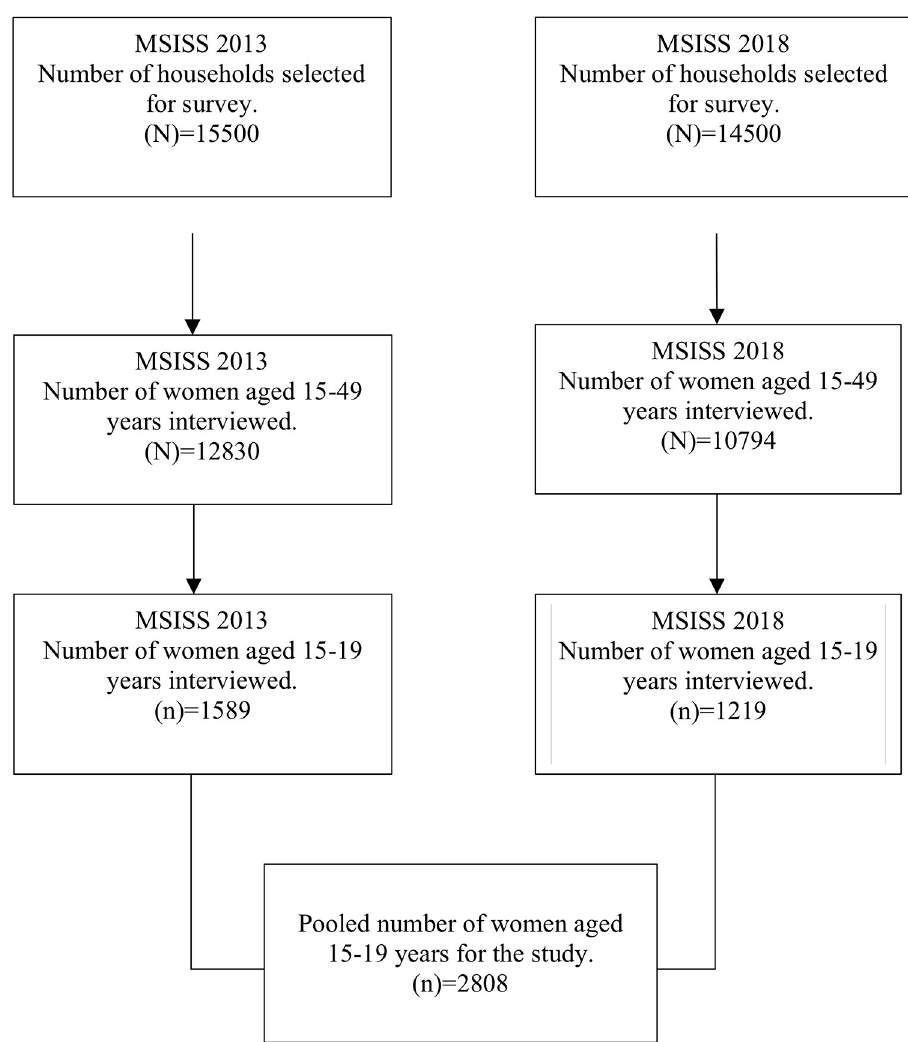
Fig 1. Flow chart for the selection of the study